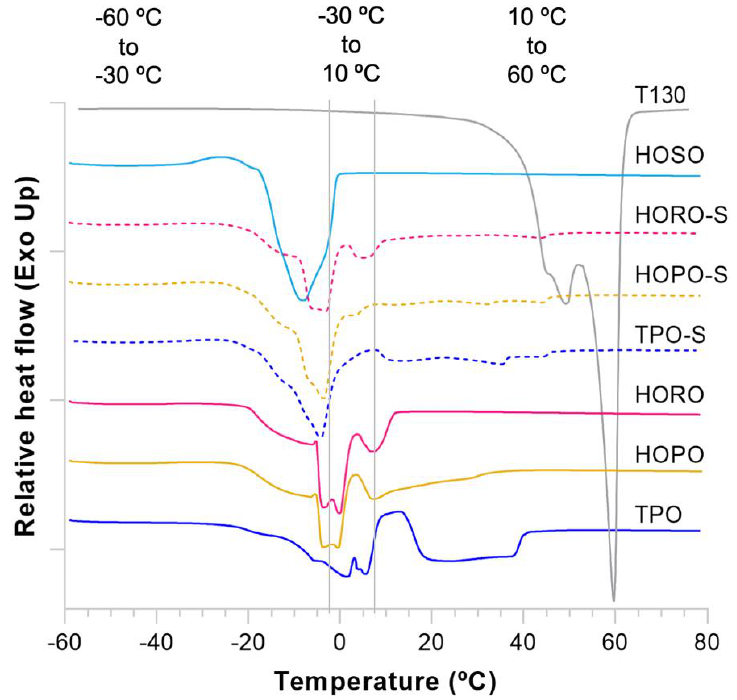
Figure 3. Differential scanning calorimetry of melting curves (endothermic thermogram) for oils, emulsifier and shortenings. Deviations above the baseline are exothermic; Deviations below the baseline are endothermic. Table 6. Crystallization onset and peak temperature (°C), and enthalpy of fats ∆H (J/g). Temperature Ranges Fat